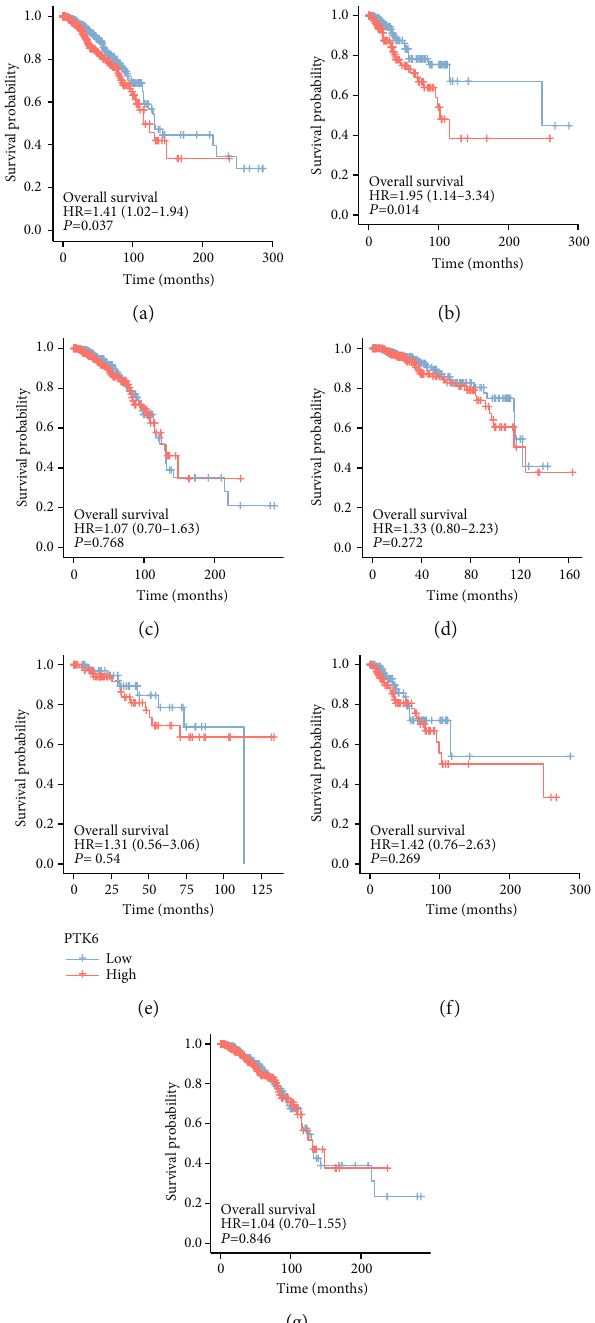
Figure 6: Survival curves were calculated using Kaplan-Meier estimates for the exploration of the possible in fl uence of PTK6 expression on overall survival of BC patients. (a) All BC patients. (b) Patients with negative PR status. (c) Patients with positive PR status. (d) Patients with negative HER2 status. (e) Patients with positive HER2 status. (f) Patients with negative ER status. (g) Patients with positive ER